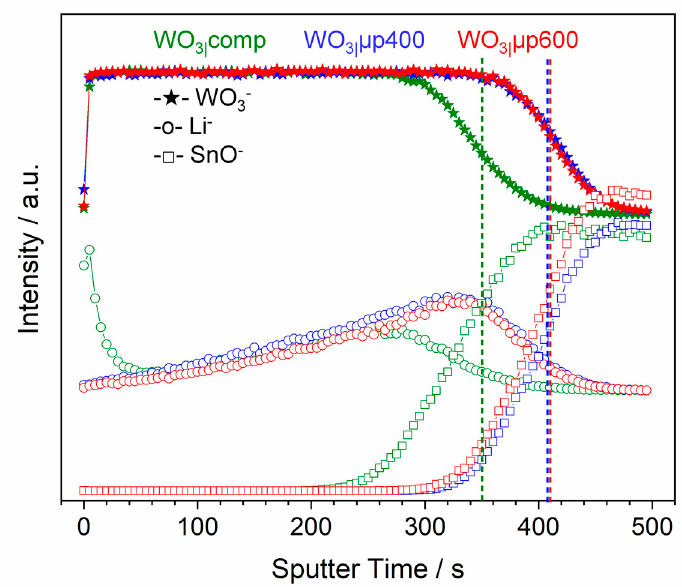
Figure 11. Depth profiles obtained from ToF-SIMS analysis of the WO 3 − (- (cid:70) -), Li − (-o-) and SnO − (- □ -) signals for thin films of WO 3| comp (green), WO 3| µp400 (blue) and WO 3| µp600 (red) films intercalated at − 1.0 V for 300 s. Dashed lines mark the approximate position of the interface between WO 3 and FTO estimated from the WO 3 − and SnO − signals.